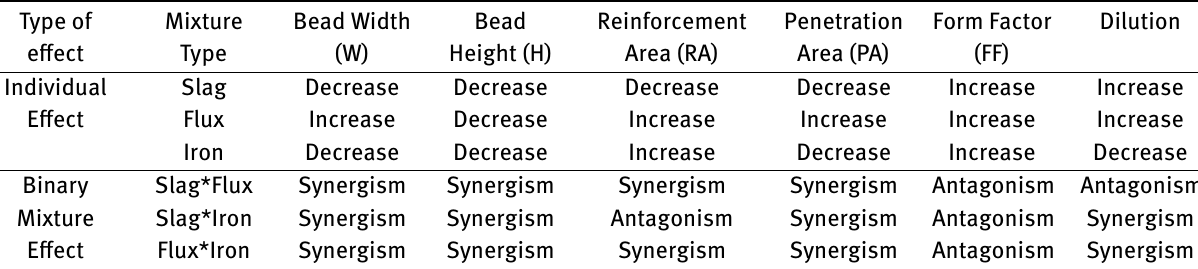
Table 4: Summary indicating effect of individual and binary mixtures on weld bead characteristics Type